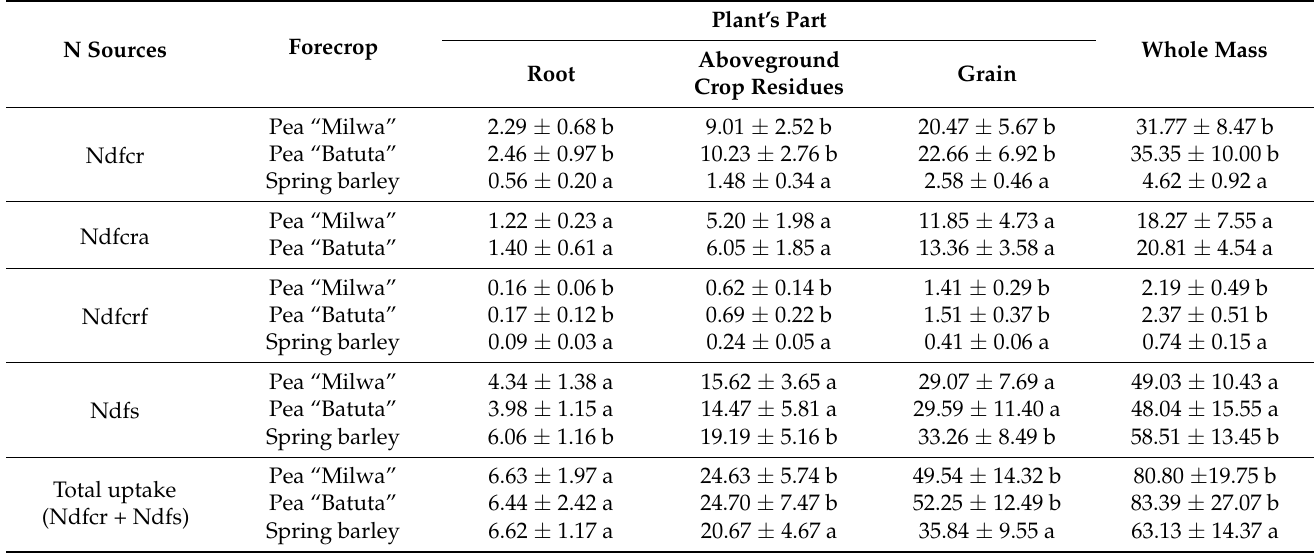
Table 6. Nitrogen uptake by winter triticale from different sources depending on the forecrop, kg N · ha − 1 (averages ±